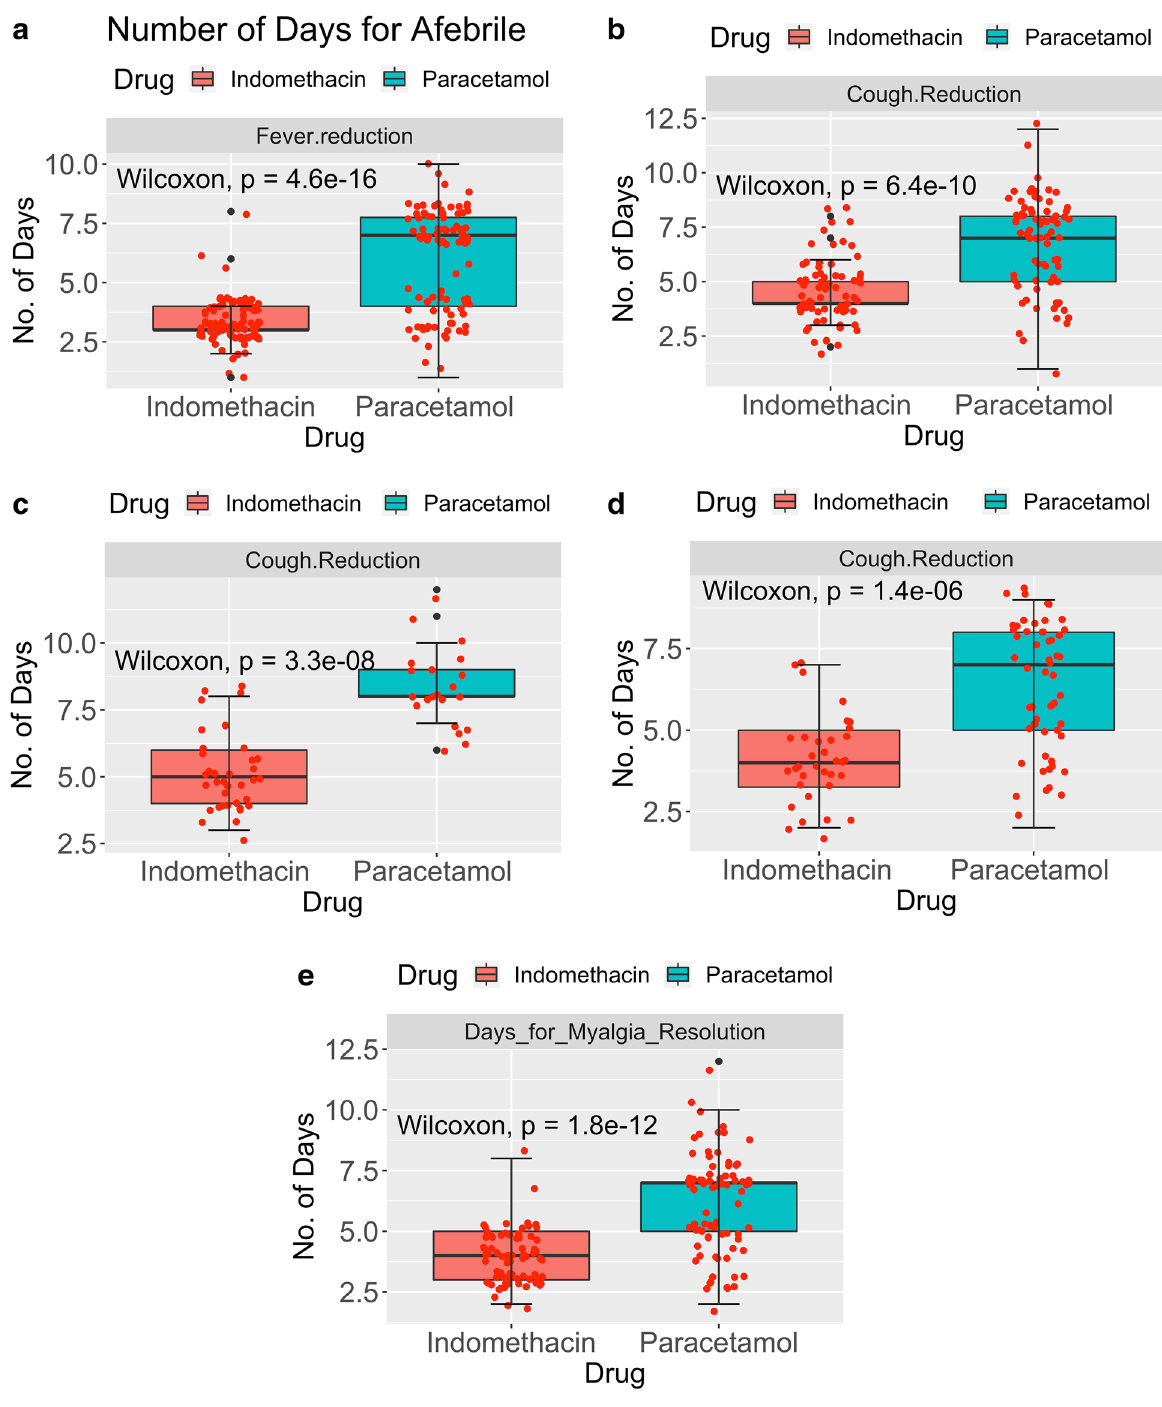
Figure 3. ( a ) Number of days for Afebrile. N Indomethacin = 95; N Paracetamol = 98. ( b ) Number of days for cough reduction. N Indomethacin = 70; N Paracetamol = 75. ( c ) Number of days for Cough Reduction—Cough on Admission 7 to 10. ( d ) Number of days for Cough Reduction—Cough on Admission 2 to 6. ( e ) Number of days for myalgia resolution. N Indomethacin = 77; N Paracetamol =